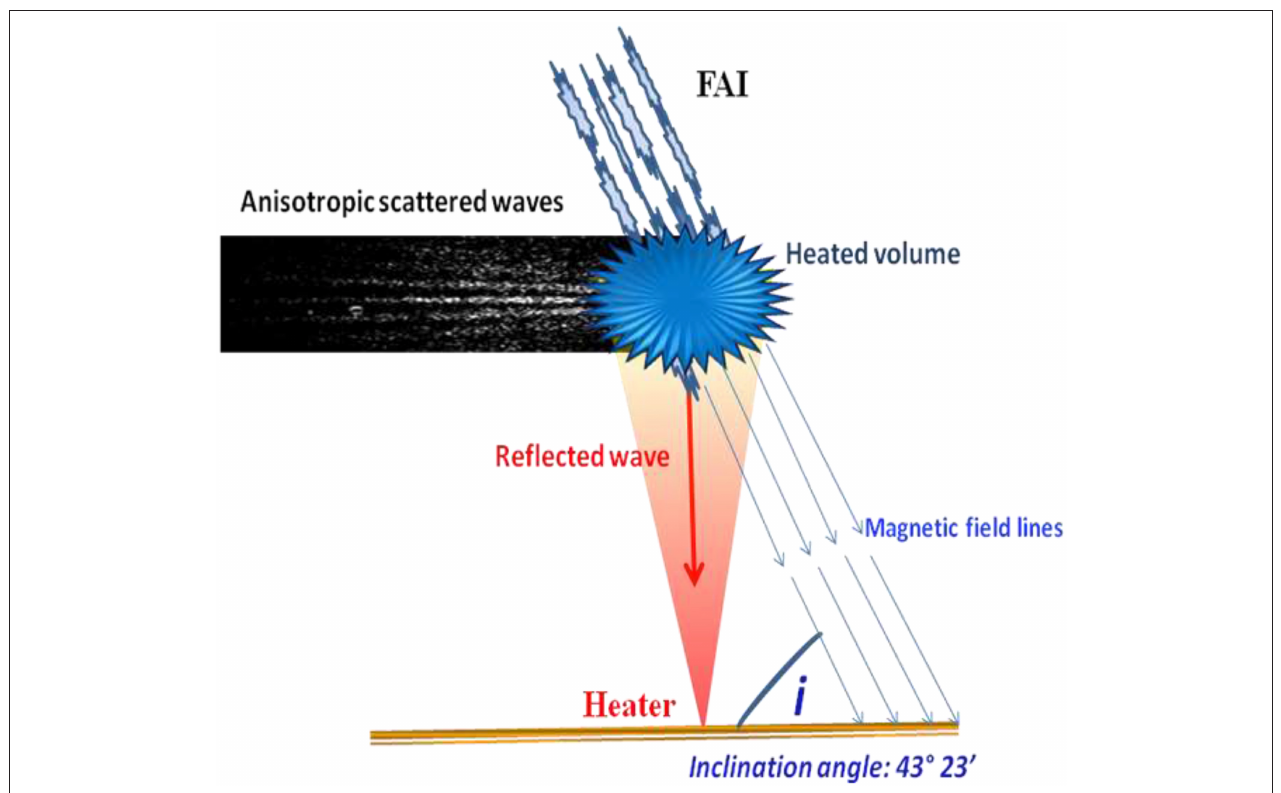
FIGURE 7 | Schematic of the aspect scattering of the radio wave by FAIs above Arecibo heater.